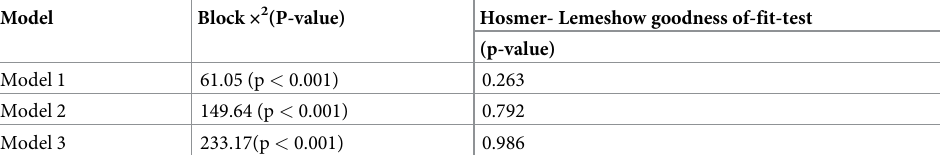
Model 1: Examined the joint effects of socio-demographic factors Model 2: Used socio-demographic factors with p-value < 0.20 in Model 1, and environmental factors Model 3: Built on variables with p-value < 0.20 in Model 2 and included behavioral